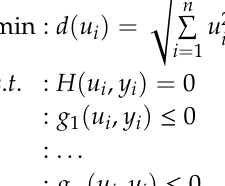
Figure 6. Flowchart of developed reliability algorithm.